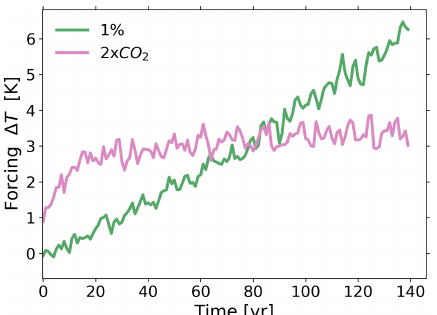
Figure 4. Forcing temperature (cid:49)T (t) for 1% and 2 × CO 2 rad ex-